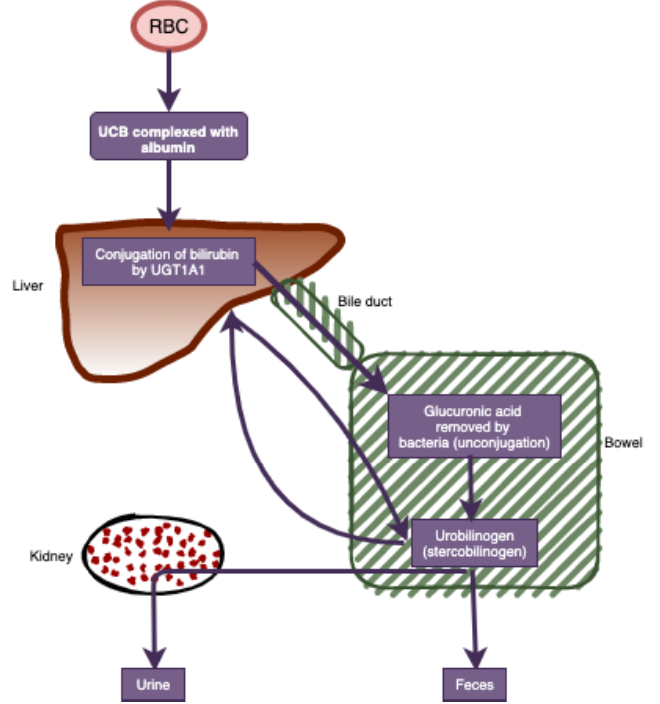
Figure 1. Heme degradation pathway. RBC, red blood cells; UCB, unconjugates bilirubin; UGT1A1, diphosphoglucuronyltransferase.